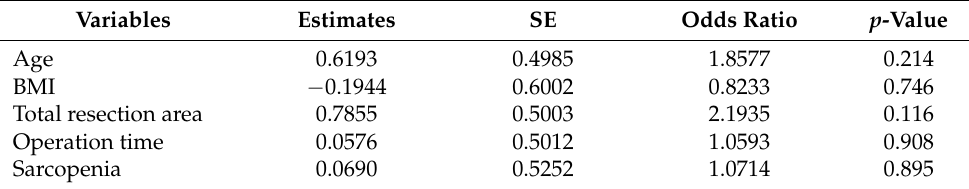
Table 5. Parameter estimates of main effects for changes in REE using generalized linear models.